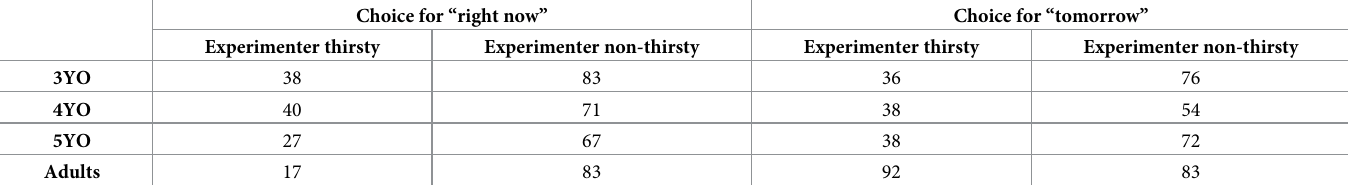
Table 2. Percentage of participants choosing crisps for the experimenter as a function of age and condition.